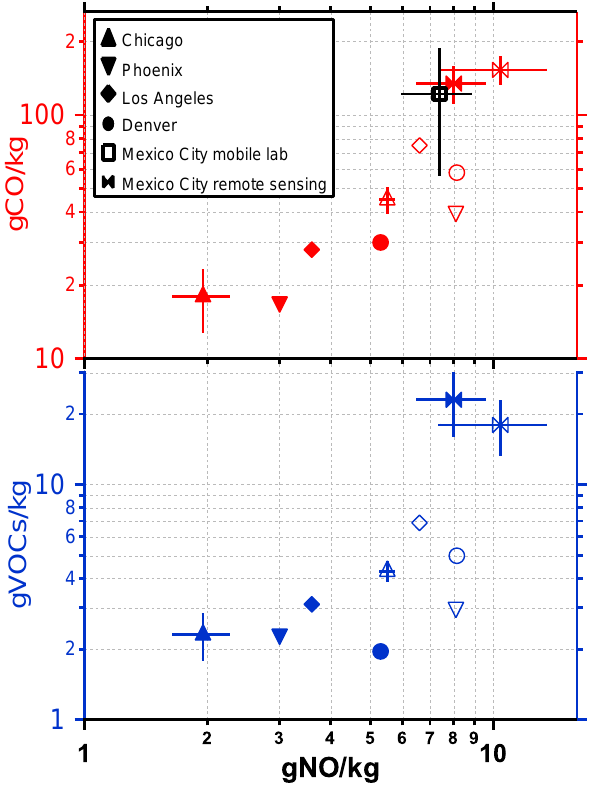
Fig. 2. Comparison of fuel-based emission factors in this work with those measured with remote sensing in 2000 (open symbol) and 2006 (filled symbol) in Mexico City (Schifter et al., 2003, 2008) and in several US cities (Bishop and Stedman, 2008) for CO, NO and hydrocarbons (as propane equivalents). For measurements in US cities, open symbols represent 1999 data whereas filled sym- bols represent 2005 data (for Denver and Los Angeles) and 2006 data (for Phoenix and Chicago). For US measurements, error bars represent standard errors of the mean plotted for Chicago as repre- sentative for all other cities. Error bars for measurements in Mexico City represent one standard